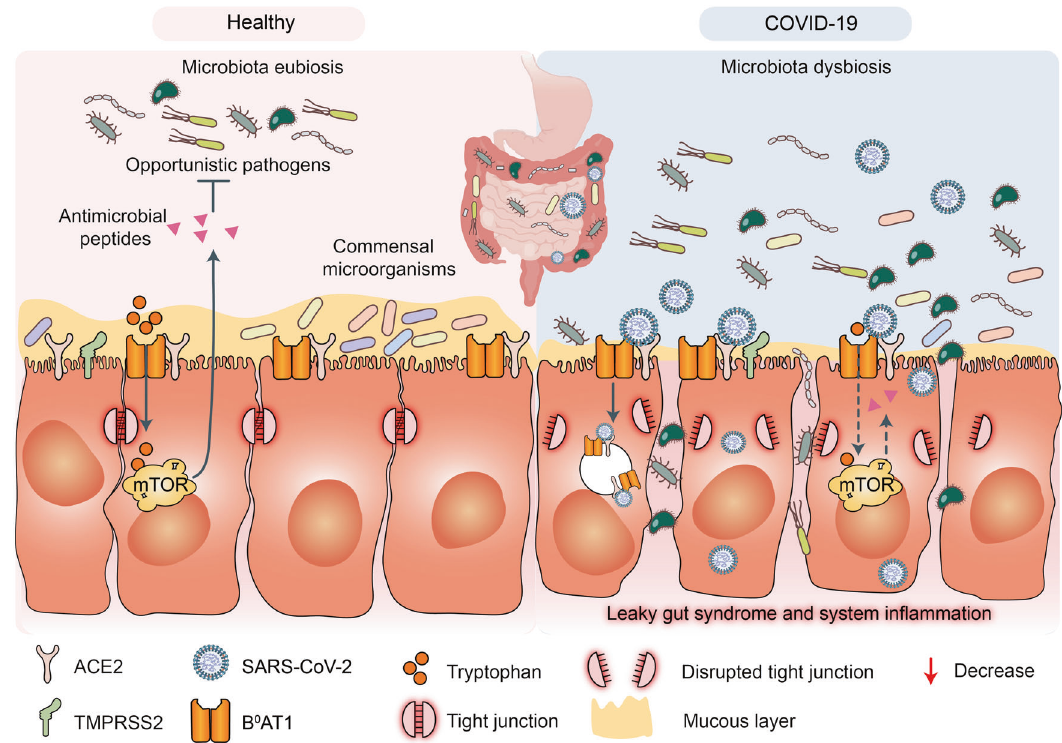
Fig. 4 Potential mechanisms of cytokine storm and secondary pathogen infections resulting from gut microbiota dysbiosis in patients with COVID-19. Gut microbiota are also disrupted by SARS-CoV-2 infection which potentially triggers cytokine storm and secondary pathogen infections. B 0 AT1 mediates neutral amino acid uptake by luminal surfaces of intestinal epithelial cells. It is also a molecular ACE2 chaperone. B 0 AT1 substrates such as tryptophan and glutamine activate antimicrobial peptide release, promote tight junction (TJ) formation, downregulate lymphoid proin fl ammatory cytokines, and modulate mucosal cell autophagy via mTOR signaling. As ACE2 is a molecular B 0 AT1 chaperone, ACE2-associated B 0 AT1 may be internalized during SARS-CoV-2 infection, decrease B 0 AT1 on cell membranes, promote gut opportunistic pathogen invasion, facilitate cytokine storms, and exacerbate